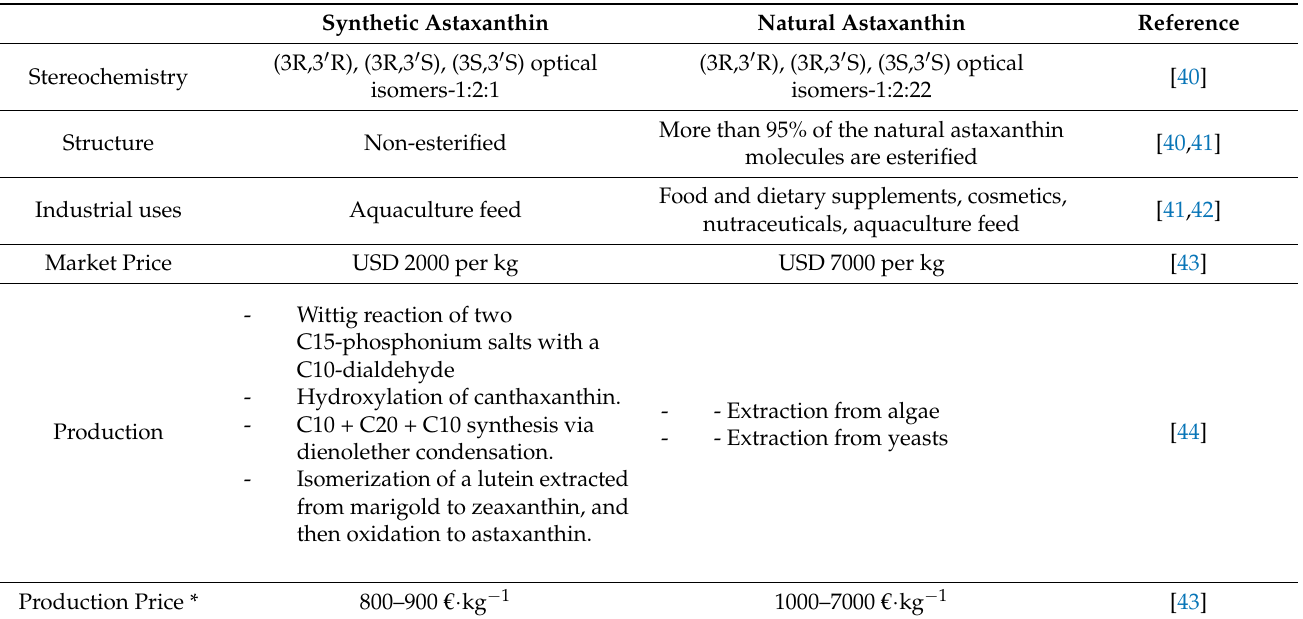
Table 2. Differences between synthetic and natural